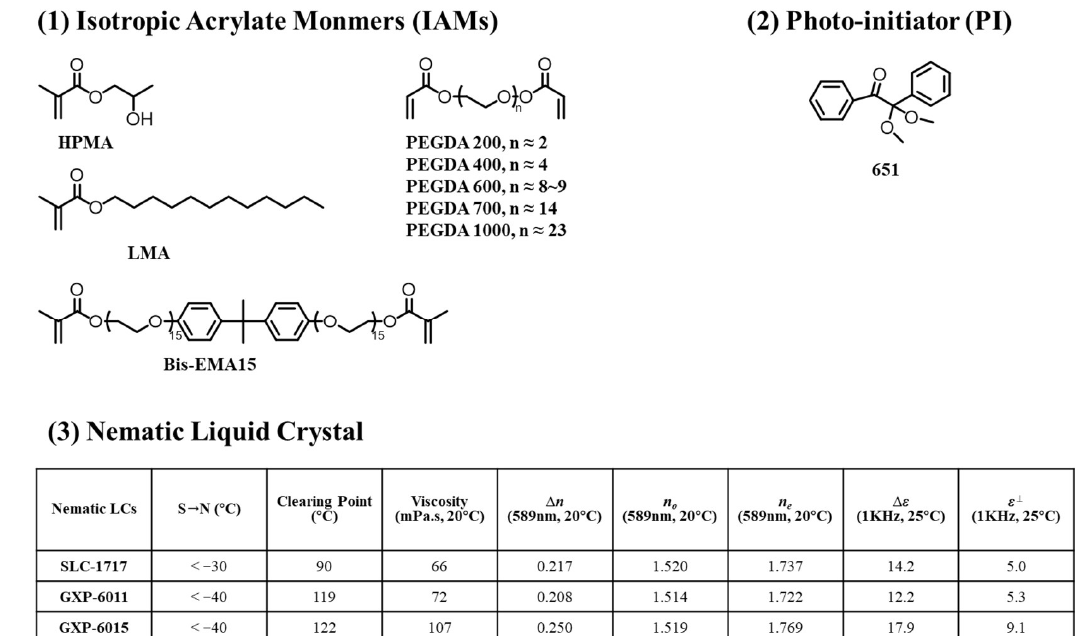
Table 1. The compositions (wt.%) of all